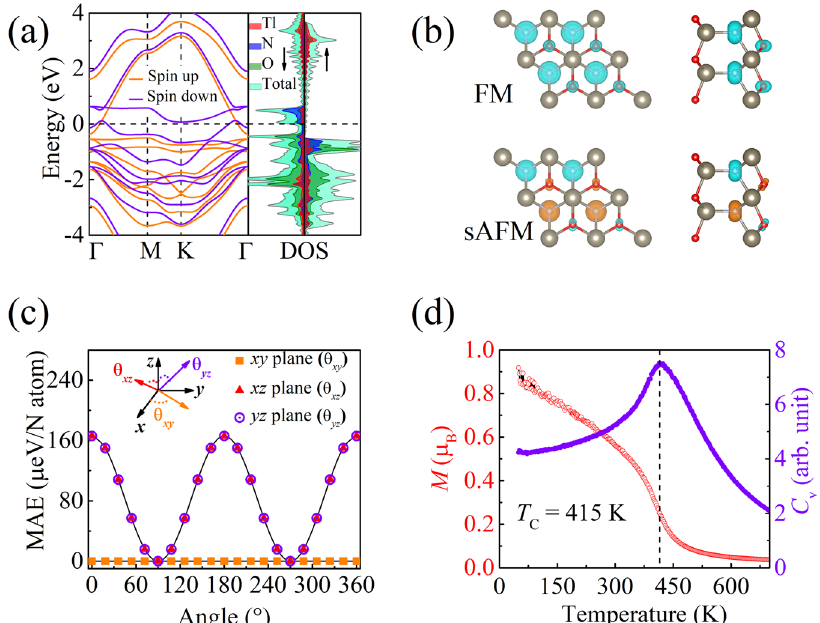
Fig. 2 Electronic and magnetic properties. a The spin-polarized band structure (left) and the element-resolved PDOS (right) at PBE level for FE − WZ ′ X 2 NO 2 monolayer near the Fermi level, which is set to zero. Γ (0, 0, 0), M (1/2, 0, 0), and K (1/3, 1/3, 0) are the highly symmetric points in reciprocal space. b Top and side views of the spin charge density for sAFM and FM FE − WZ ′ X 2 NO 2 monolayers. The isovalue is 0.1 electron per Å 3 . Spin-up and spin-down electrons are colored as cyan and orange, respectively. c Angle-dependent magnetic anisotropic energy with the magnetic moments lying on xy , xz , and yz planes. The energies for the case of the spin along the easy magnetization planes ( xy / xz ) are set to zero. The angles between the spin vector and the x , y , and z axes are shown in the inset. d The temperature dependence of the magnetic moment M (in red) and speci fi c heat (in violet) of the FE − WZ ′ Tl 2 NO 2